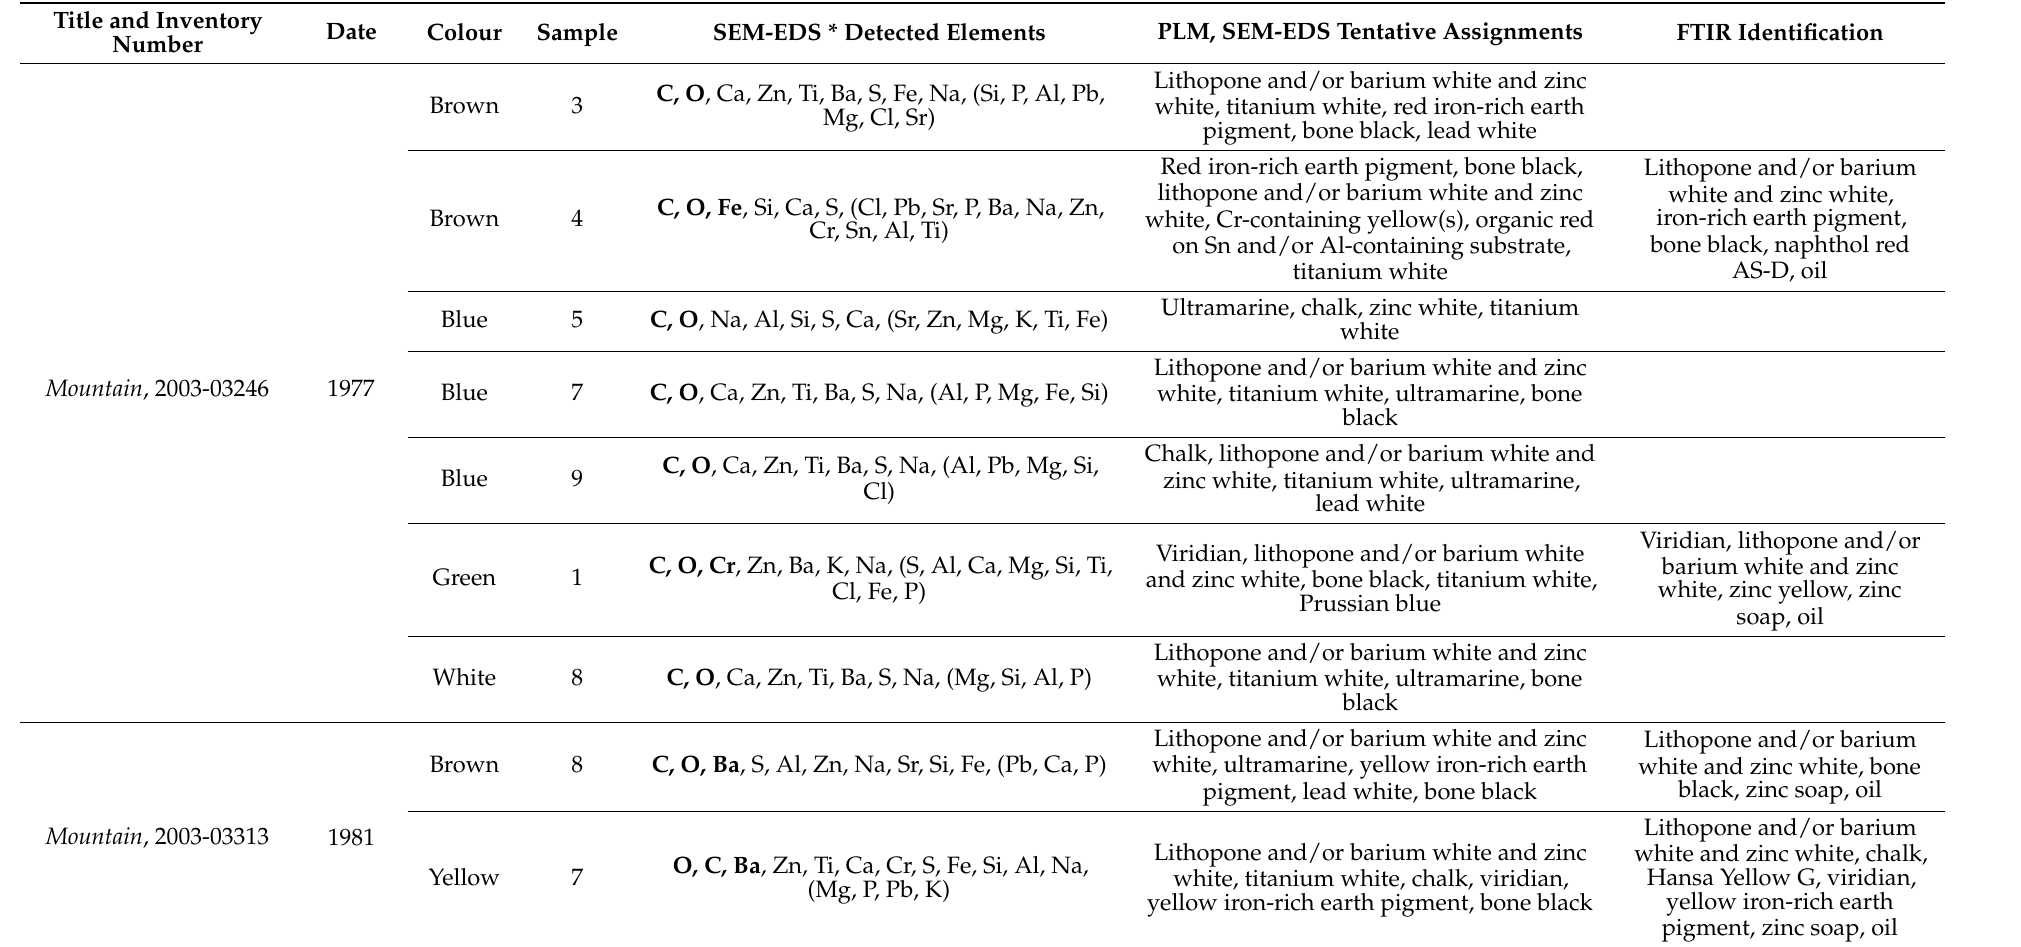
Table A1. Summary of the materials identified or tentatively determined in the paint samples extracted from the investigated